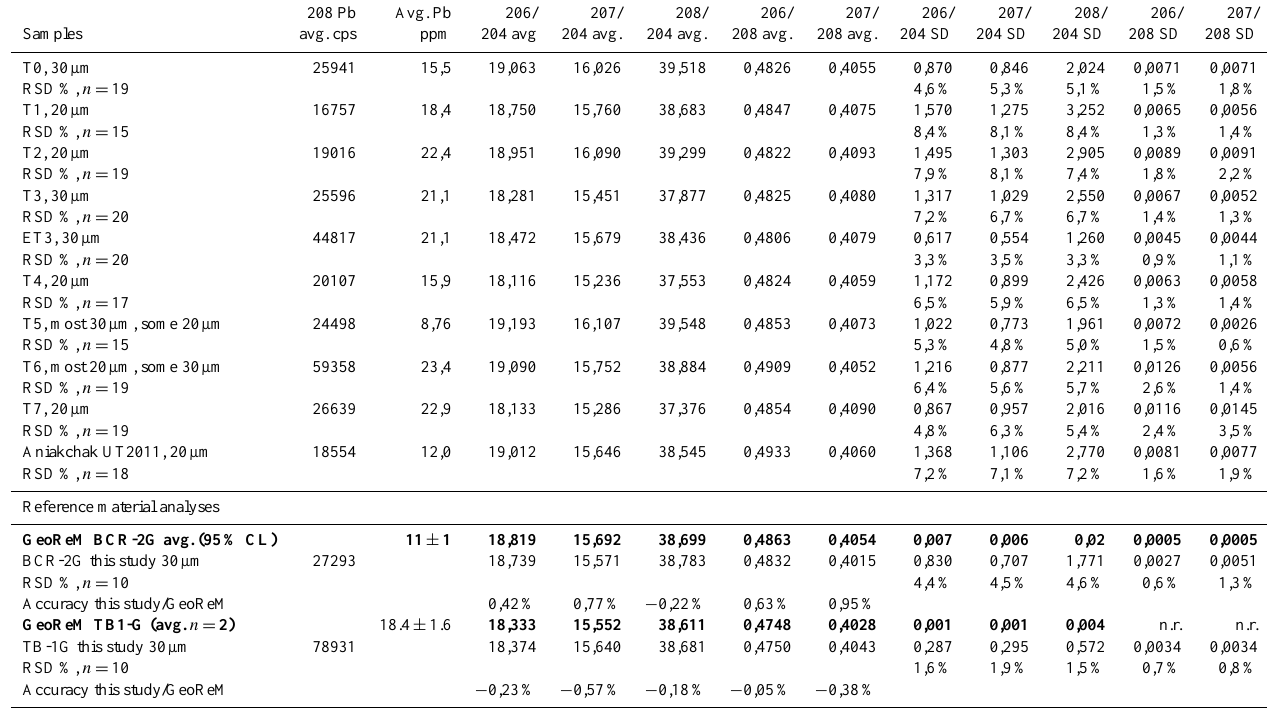
Table 4. Average Pb isotopic values collected on single glass shards from Lake El’gygytgyn tephra. Avg. = average; SD = standard deviation; n.r. = not reported; RSD% = relative standard deviation given as percentage (+ std dev/mean ×